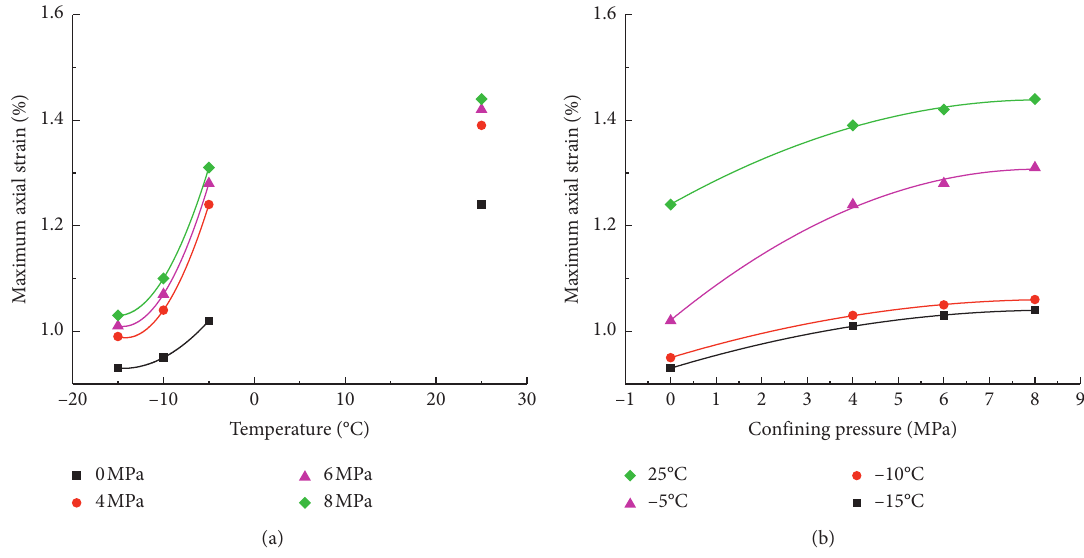
Figure 9: Maximum axial strain curves under different conditions: (a) temperature, and (b) confining